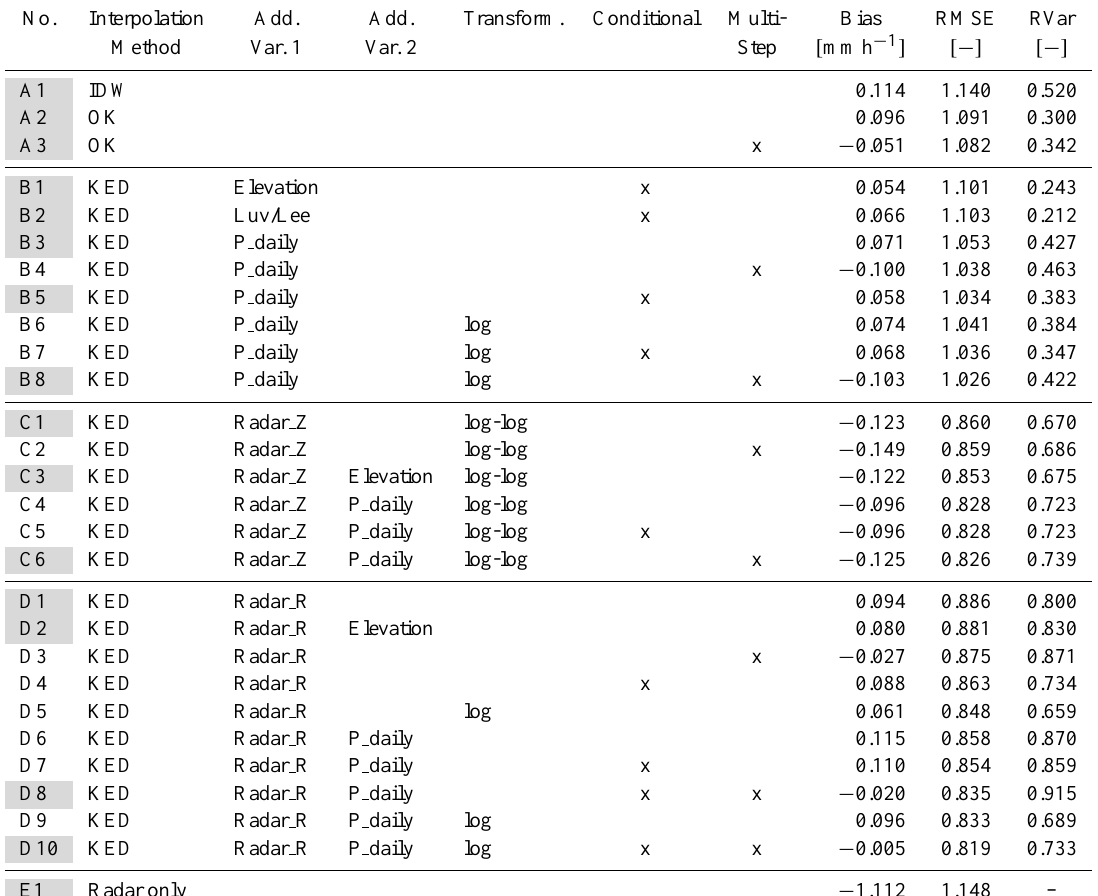
Table 5. Precipitation cross-validation results using all summer events averaged over time steps with an average precipitation exceeding a threshold of 1mmh − 1 (“log”: all Y k are log-transformed, “log-log”: both Z and all Y k are log-transformed; highlighted no. are presented in Fig.